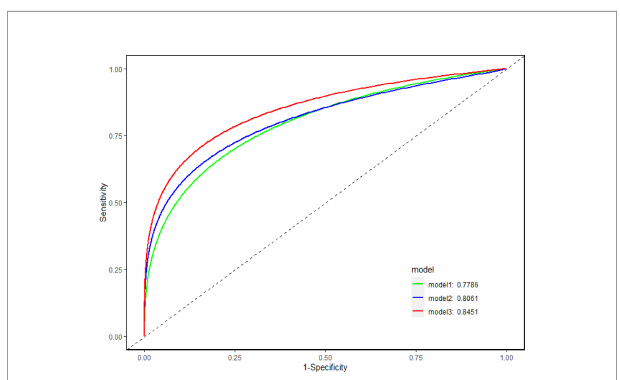
FIGURE 2 | Discriminatory accuracy of the models. Discriminatory accuracy for predicting the risk of IAC was assessed by constructing receiver operating characteristic (ROC) curves and calculating the area under the curve (AUC). In model 1, the AUC value was 0.789 based on clinical variables only (age, gender, BMI, hypertension, smoking) data. The AUC was increased to 0.806 in model 2 with CEA, and 0.845 in model 3 with sCD27 and